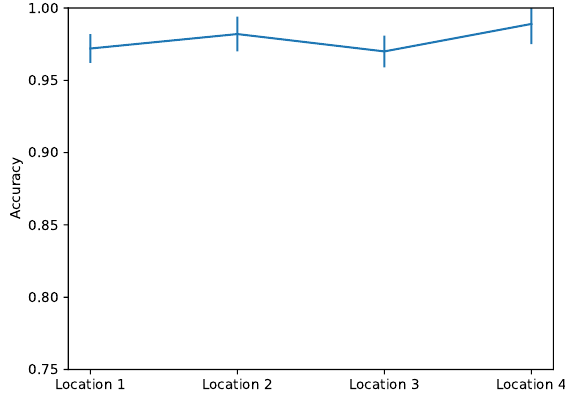
Figure 14. Accuracy for damage localization. MIMs monitoring five natural modes over a 10 day period are